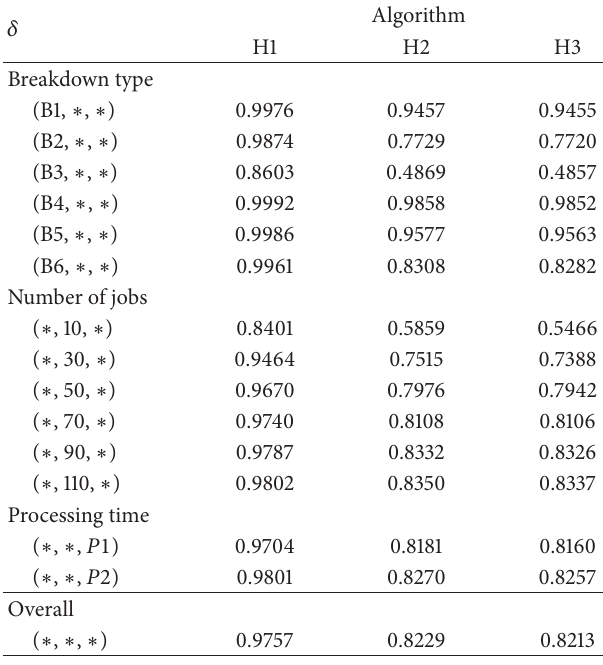
Table 1: Problem parameter.